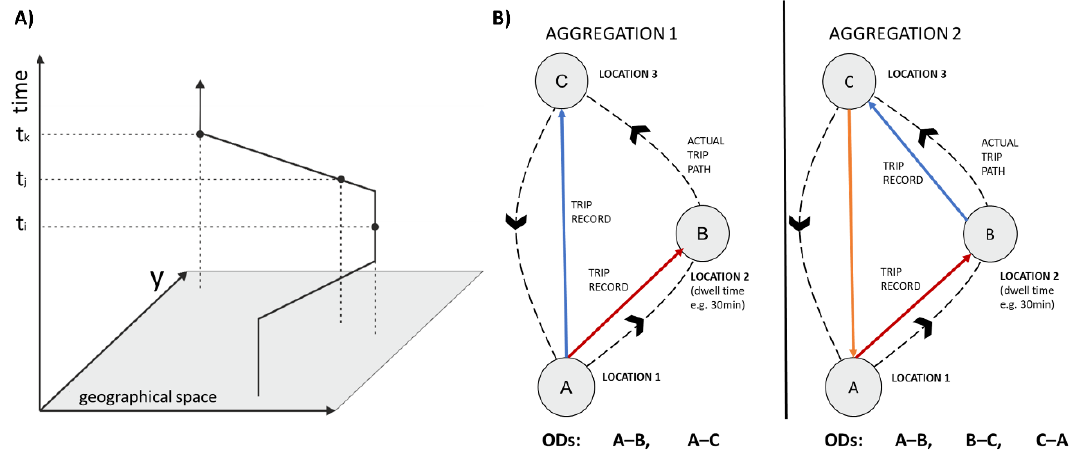
Figure 1. Illustration of a space–time trajectory consisting of a series of presence snapshots ( A ). The snapshots can be aggregated into trip records in multiple ways in mobile phone datasets, which can lead to differences in the resulting origin–destination (OD) pairs ( B ).